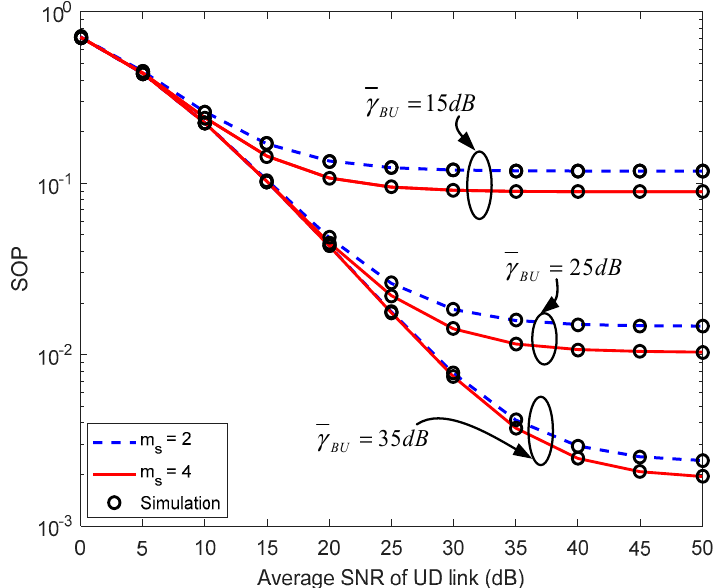
Figure 2. SOP performance of the network under different values of m s and average SNR of the B-to-UAV link at h u = 1 km, ρ e = 3 × 10 − 2 , and γ UE = 2 dB.